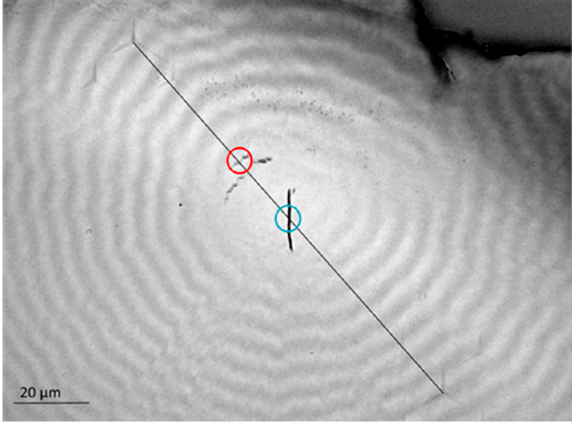
Figure 1. Optical microscopy image of the banded morphology of P3HB-co-3HV after crystallization at 60 °C. Indentations of h ≈ 100 nm separated by 1 µm were produced along the distinct line. Circles identify two cracks appearing across the straight line, the blue one denoting the crack in the center of the spherulite.